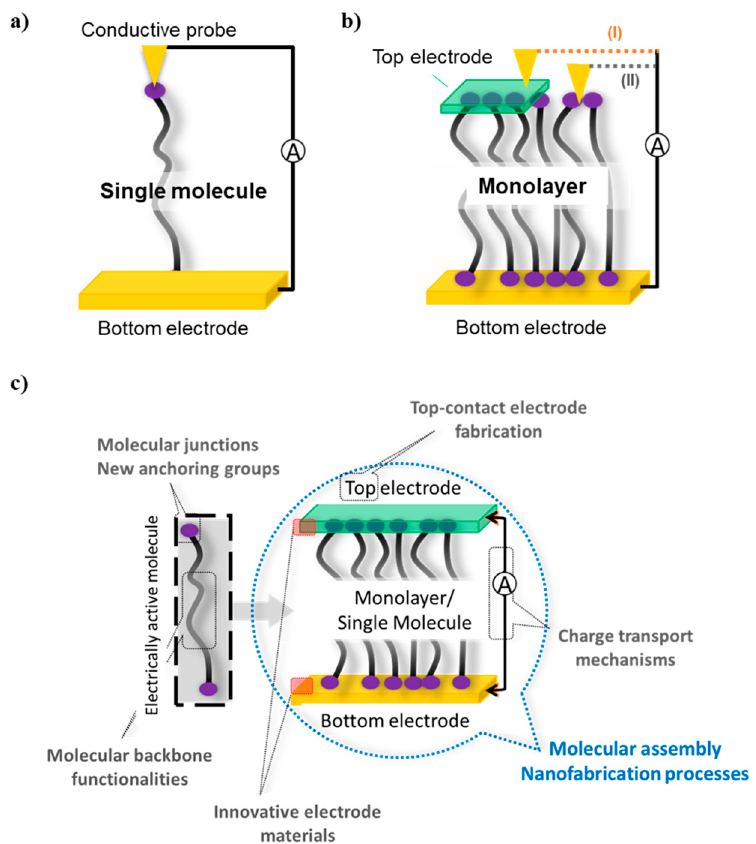
Figure 1. ( a ) Scheme of a molecular device based on single-molecule junctions. The electrical contact is made directly with a conductive probe. ( b ) Scheme of a sandwiched large-area molecular device. The electrical contact can be made using a top-contact electrode (I), which is more oriented to mass production, or directly above the organic monolayer (II), to determine the electrical properties of the electrode | monolayer structure. ( c ) Main challenges to be addressed in molecular electronics.